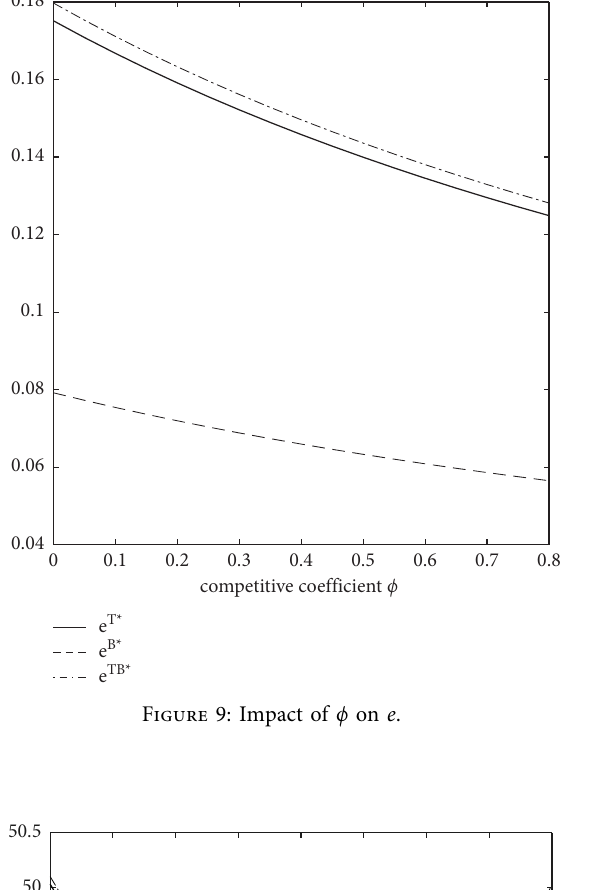
Figure 11: Impact of ϕ on q